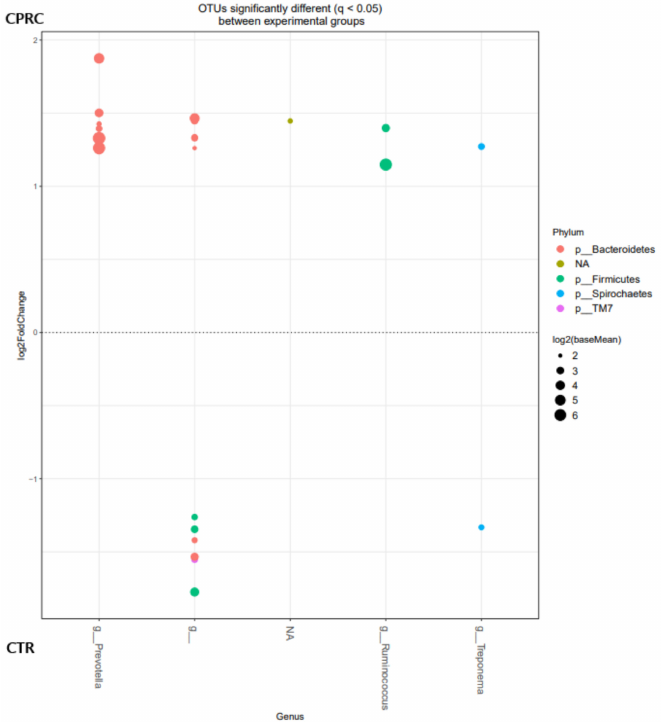
Figure 2. OTUs at the genus level were significantly different (q < 0.05) between rumen samples of cows fed the control (CTR; below) and concentrate with cold-pressed rapeseed cake (CPRC; above). Each point represents a single OTU colored by phylum and grouped on the x -axis by taxonomy. The size of the point reflects the log2 mean abundance of the sequence